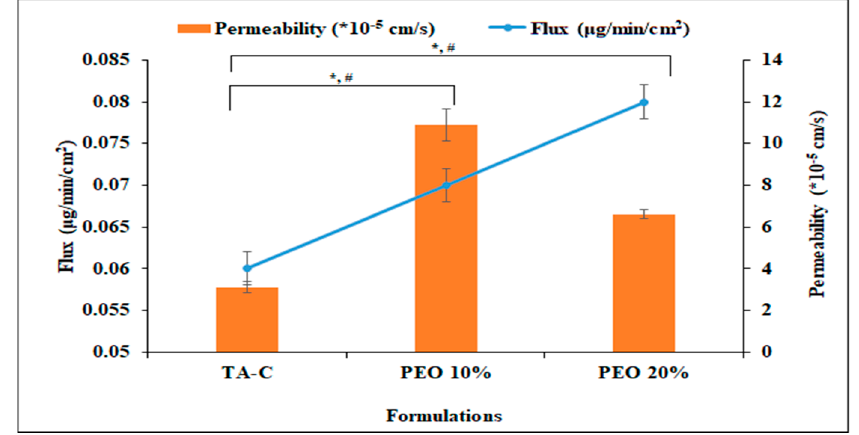
Figure 3. In vitro drug permeation of triamcinolone acetonide from 10% and 20% w / w PEO and films and polyethylene oxide (TA-C) formulation (mean ± SD, n =